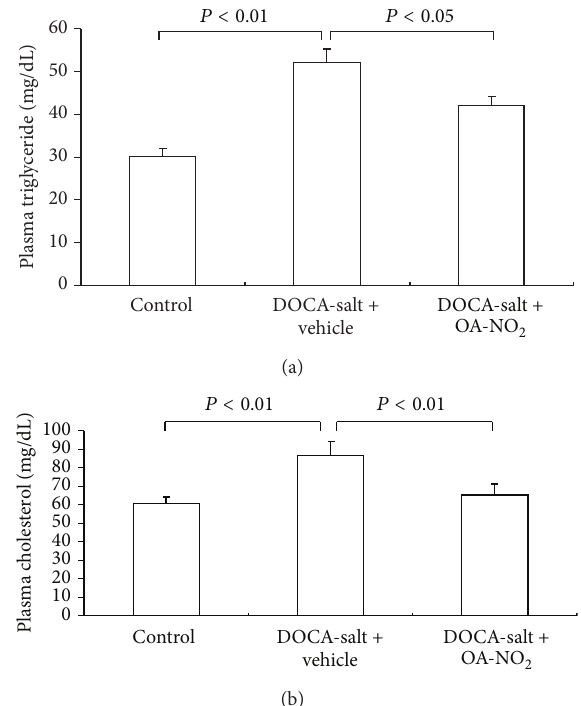
Figure 3: Effect of OA-NO 2 on plasma triglyceride (a) and choles- terol (b) in DOCA-salt hypertensive mice. Control: 𝑛 = 5 ; DOCA- salt + vehicle: 𝑛 = 8 ; DOCA-salt + OA-NO 2 : 𝑛 = 8 . Data are shown as mean +